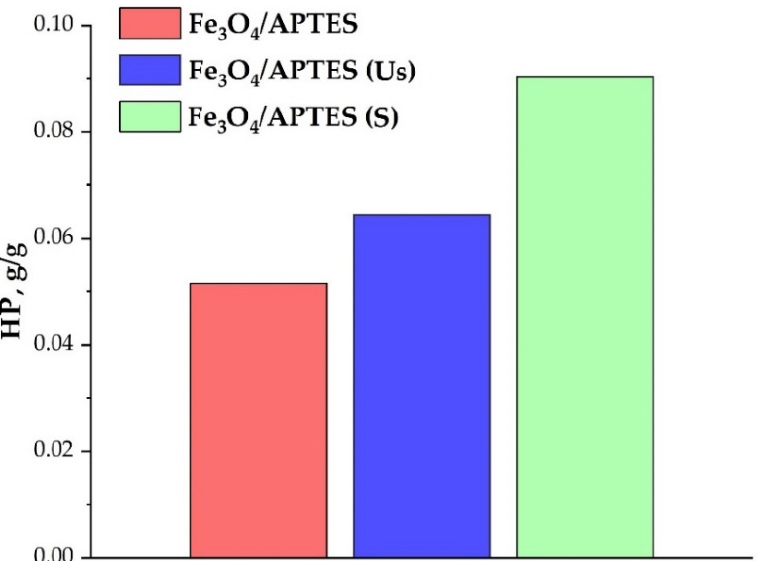
Figure 5. Amount of HP for a complete coverage of 1 g MNPs surface given in g ( ζ ~ − 20 mV, pH 3, 0.01 M KCl).